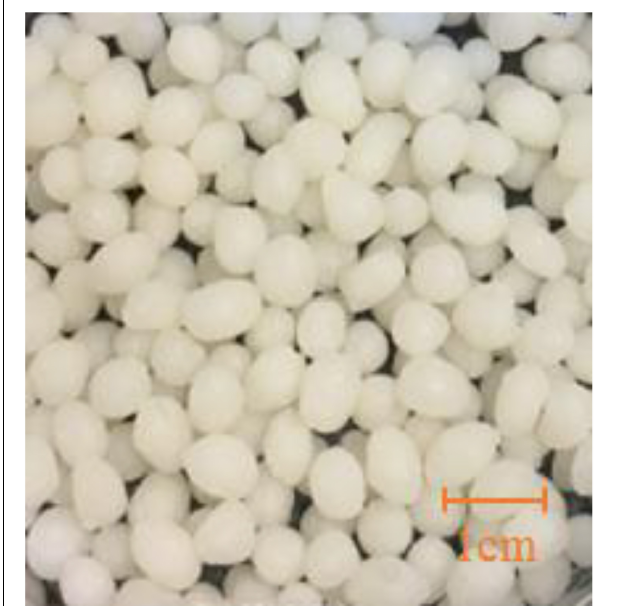
FIGURE 3 | Floating SA-EC microcapsules with algicidal powder as core material, SA as wall material and EC as the coating material. (3% SA, CaCO 3 : SA of 3:4, 3% CaCl 2 , 4% citric acid, 2% EC, and crosslinking for 30